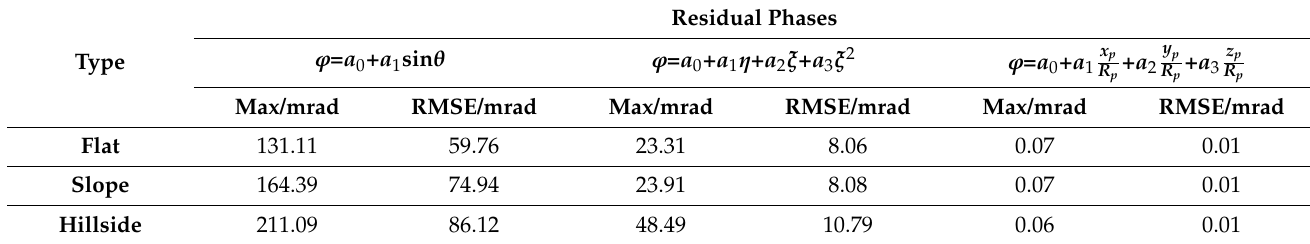
Table 1. Statistics of residual